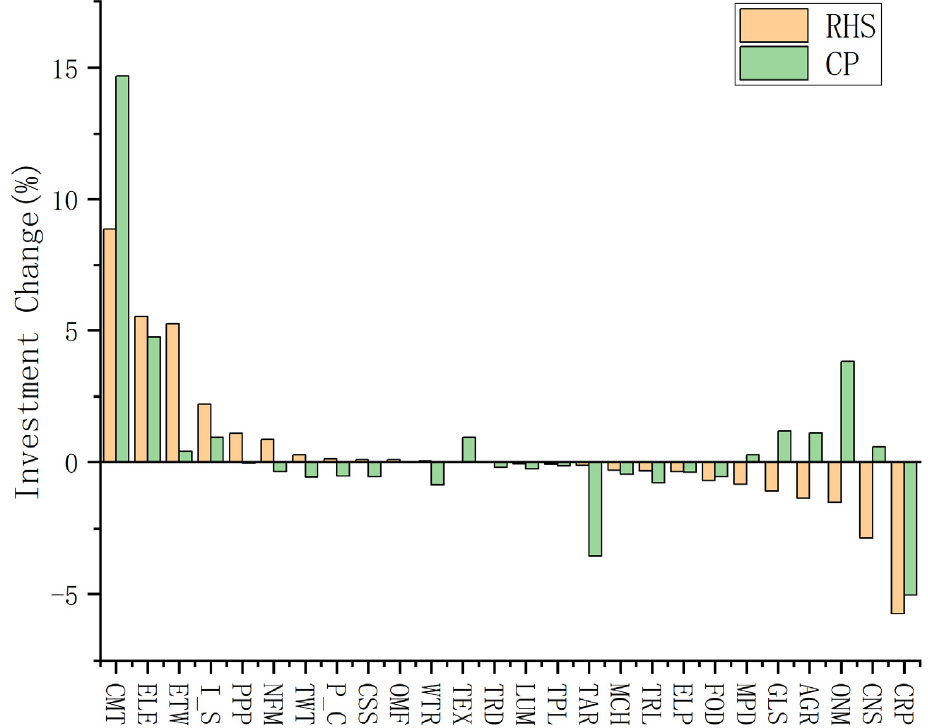
Figure 11. Investment Change under RHS and CP scenario compared with ES scenario.